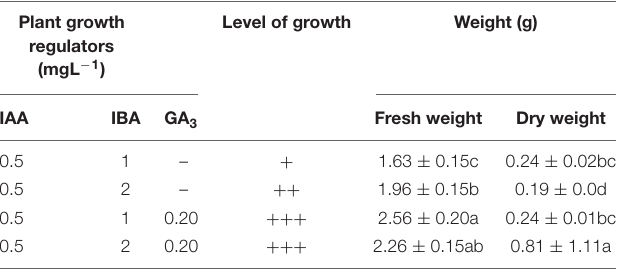
TABLE 5 | Responses of adventitious root formation from leaf culture. Plant growth regulators